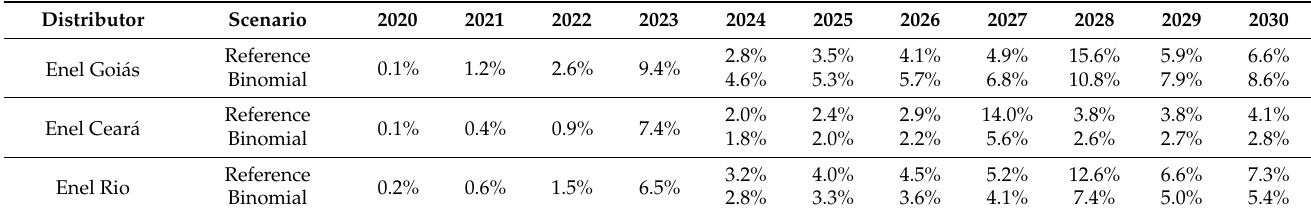
Table 12. Estimated transfer of the economic effects of the MMDG in the distributors’ tariff adjust- ments and revisions (in %).